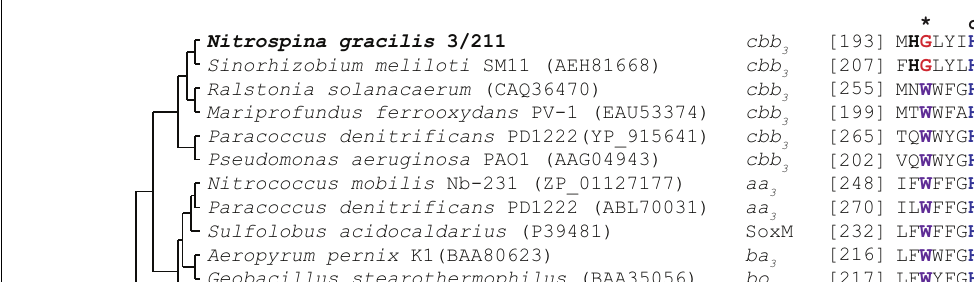
ferredoxin-sulfite reductase; SOR, Sulfite:cytochrome c oxidoreductase. Enzyme complexes of the electron transport chain are labeled by Roman numerals. Red and orange diamonds represent cytochrome c proteins and quinones, red and blue arrows the oxidative and reductiveTCA cycle, respectively.